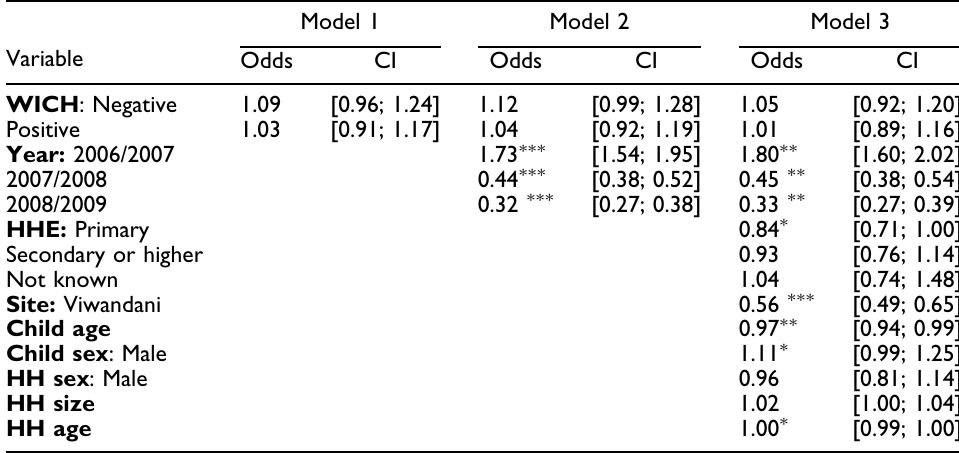
Table 3. Odds ratio from logistic regression models on overall school change (n = 15597; clusters = 6965).